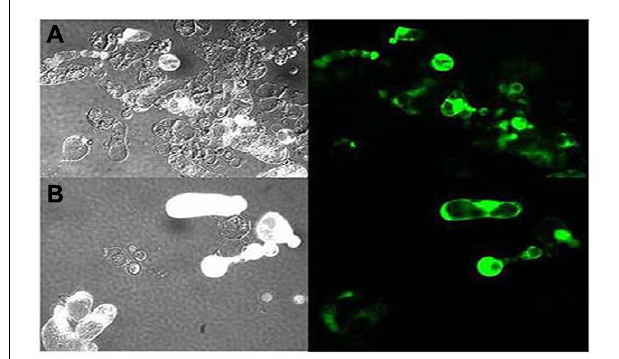
FIGURE 6 | Epifluorescent images on the morphology of protoplasts that are inoculated with transcripts for LIYV RNAs 1 and 2, and the M5 GFP defective RNA which is engineered to express the green fluorescent protein (GFP). Panel (A) shows control protoplasts (in bright field) inoculated with LIYV and M5 GFP and (B) shows fluorescence of protoplasts inoculated with LIYV and M5 GFP followed by cerulenin (50 uM) treatment. Cerulenin reduced LIYV infectivity (as assessed by protoplast fluorescence); however, in contrast, it did not have effect inTMV infectivity (see Table 1 ).